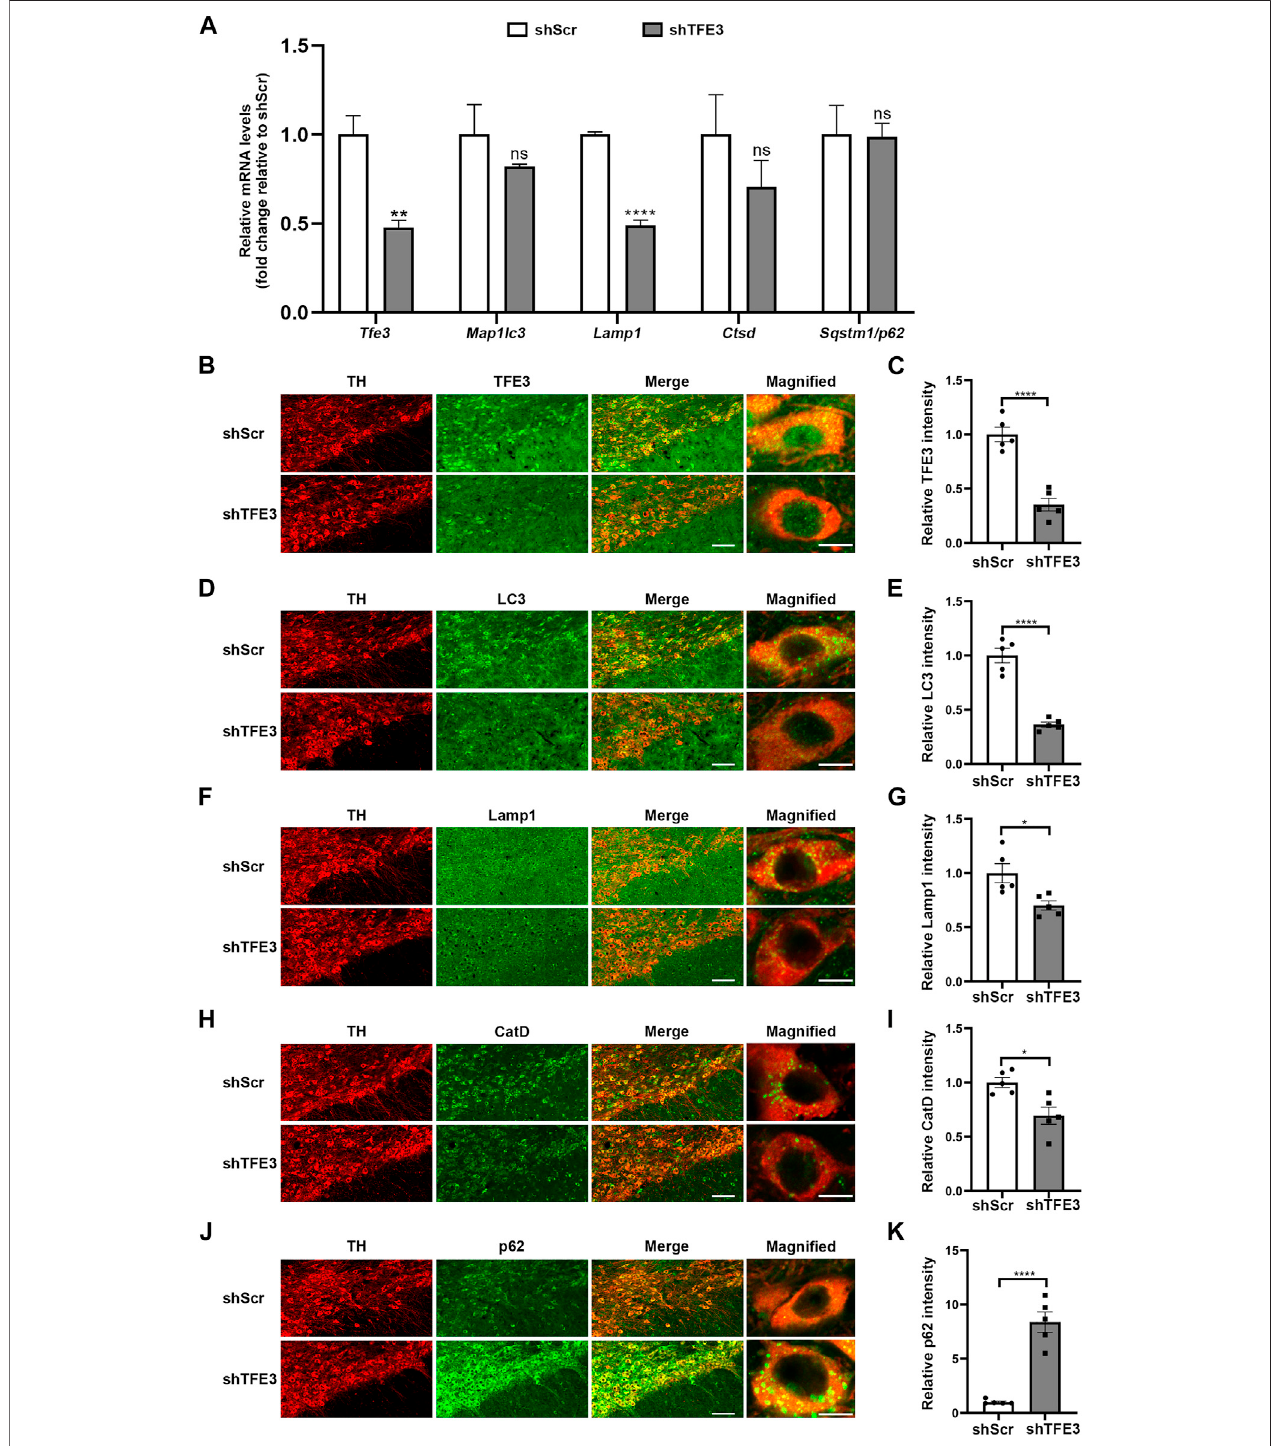
FIGURE 2 | TFE3 knockdown impairs autophagy of dopaminergic neurons. (A) Quantitative RT-PCR analysis of Tfe3 , Map1lc3 , Lamp1 , Ctsd and Sqstm1/p62 mRNA in the SN of mice injected with AAV-shScr or AAV-shTFE3. n (cid:1) 3 per group. (B, D, F, H and J) Representative images showing immuno fl uorescence for TFE3 (green, B), LC3 (green, D), Lamp1 (green, F), CatD (green, H) and p62 (green, J) in SN dopaminergicneurons (TH-positive, red) ofmice injected with AAV-shScr or AAV- shTFE3. n (cid:1) 5pergroup. Scalebars:lowmagni fi cation, 100 μ m;highmagni fi cation,10 μ m. (C,E,G,Iand K) Quantitativedataareshown.Dataareexpressed as the mean ± SEM. * p < 0.05, ** p < 0.01, **** p < 0.0001, ns, not signi fi cant, two-tailed Student ’ s t test.